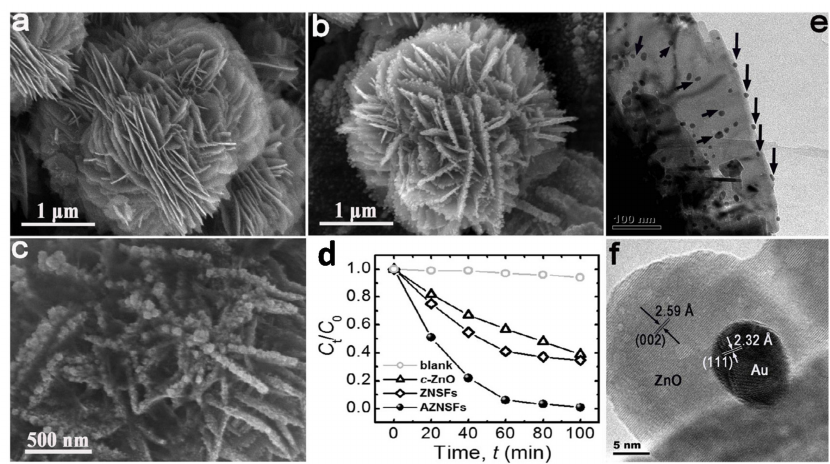
Figure 19. Hierarchical ZnO nanostructures ( a , b ) with AuNPs ( c , e , f ) used in the degradation of rhodamine-B ( d ) (Reproduced with permission from Reference [180] published by Elsevier).